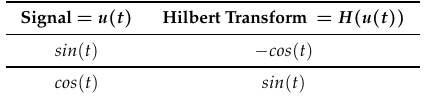
Table 5. The Hilbert Transform of sine and cosine